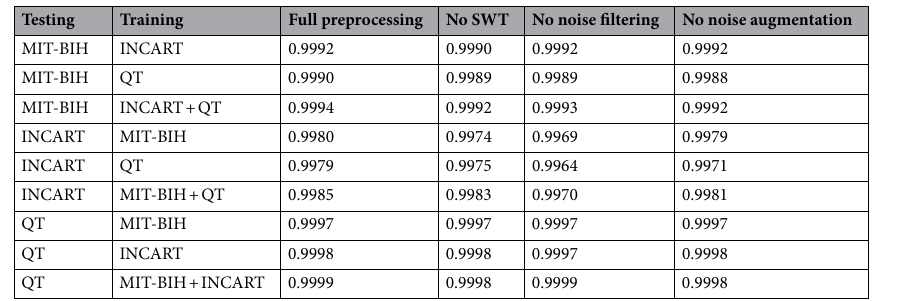
Table 3. F1 scores according to the absence of preprocessing steps in the pipeline.